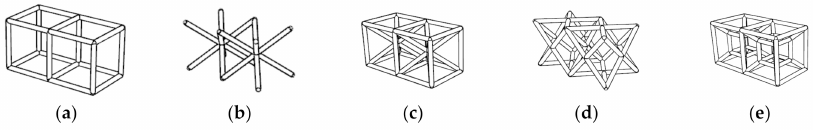
Figure 4. Three-dimensional models of different types of lattice structures: ( a ) grid; ( b ) X; ( c ) star; ( d ) cross; ( e )